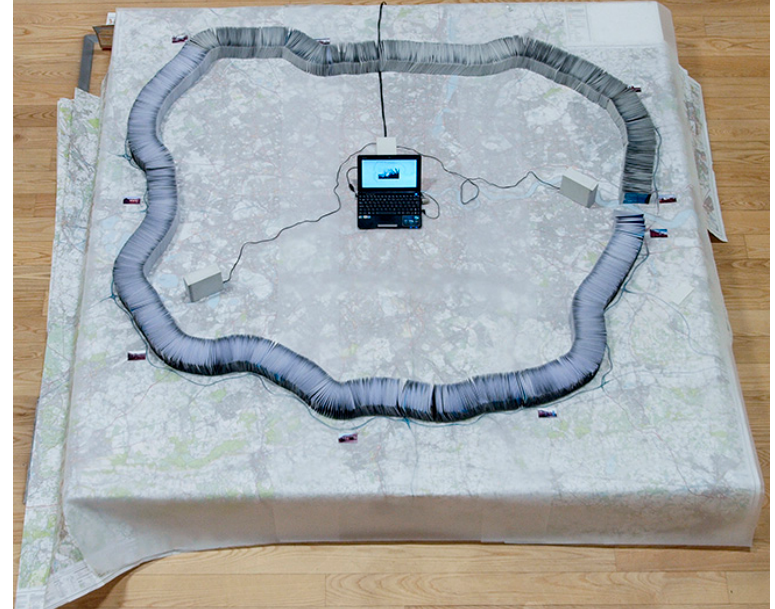
Figure 1. The Author, The M25 in 4000 Images (2014). Inkjet on matte paper, cut, folded and constructed by hand. Edition of 1. Shown as an installation with constructed map and drawing/planning document and online replay of The Great Orbital Run , with sound. From the exhibition Of Other Spaces, Sheffield Institute of Art Gallery. Photo: The Author.